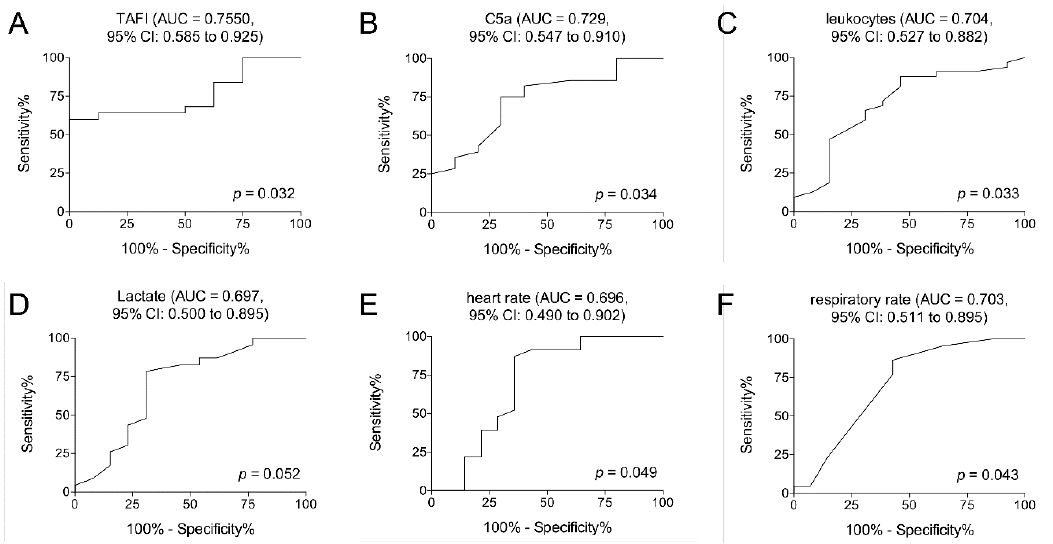
Figure 4. Receiver operating curve analyses on TAFI ( A ), C5a ( B ), leukocyte counts ( C ), lactate levels ( D ), heart rate ( E ), and respiratory rate ( F ) at admission to the emergency department to predict the development of sepsis after polytrauma are demonstrated. p < 0.05: statistically significant, AUC: area under the curve, and CI: confidence interval.